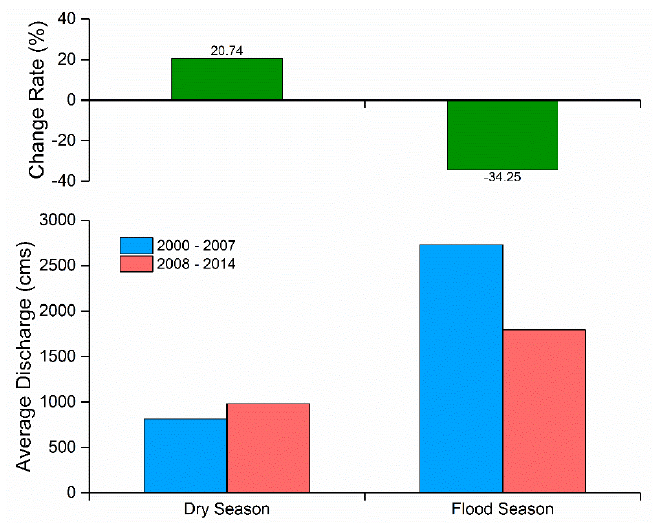
Figure 10. Intra-annual Variation in Runoff Measured at the Yunjinghong Hydrological Station before and after 2008.